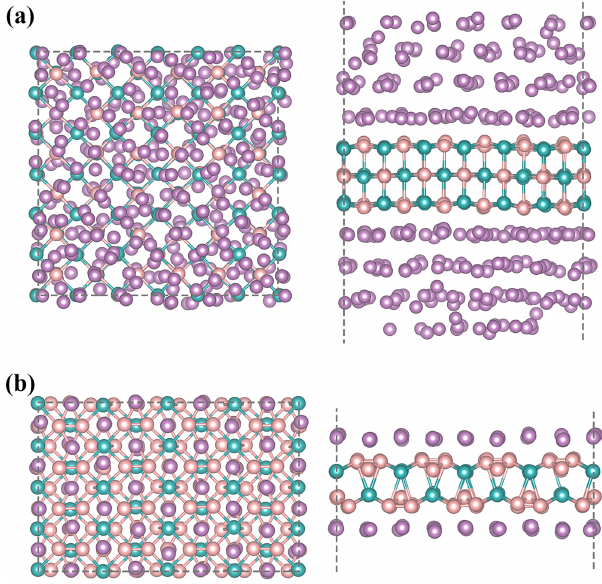
Fig. 7 Li adsorption. Top and side views of the a MoB and b MoB 3 monolayers with maximal Li adsorption after the AIMD simulations at 300